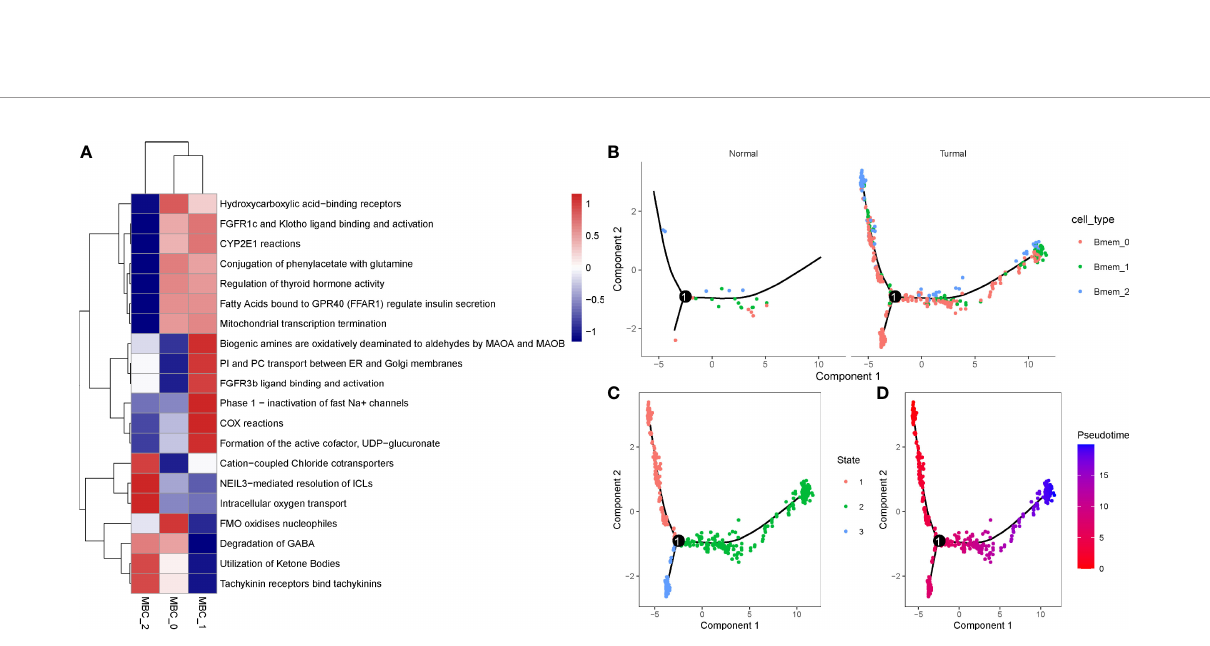
FIGURE 10 | Identi fi cation of three MBC subgroups. (A) The top 20 enriched pathways of three MBC subgroups. Blue indicates low enrichment and red indicates high enrichment. (B) The distribution of MBC_0, MBC_1, and MBC_2 in normal and tumor samples. (C, D) Cell trajectory of state1, state2, and state3. Red to blue indicates pseudotime from early to